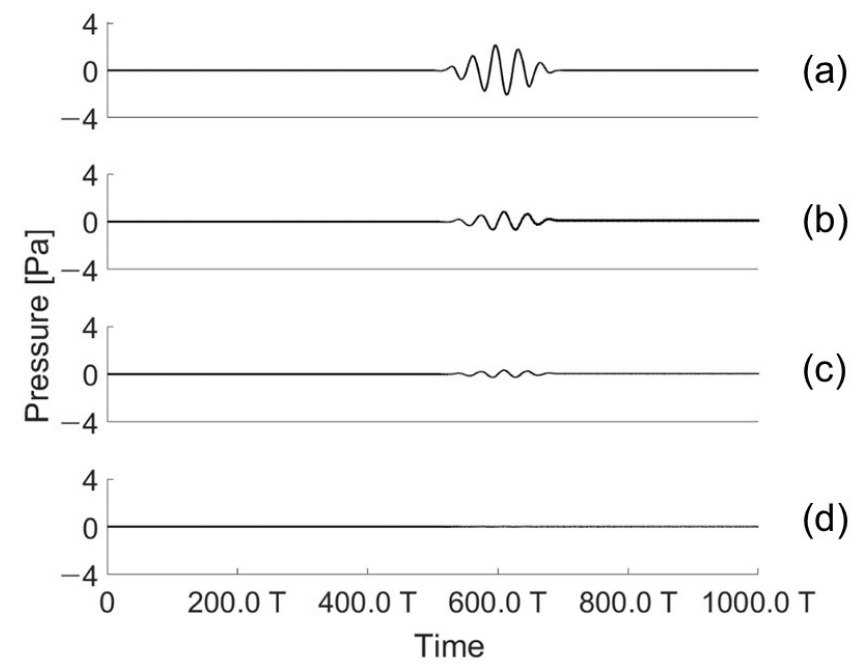
Figure 14. Acoustic signals emitted in the perpendicular direction when the array transducer is activated: ( a ) one; ( b ) two; ( c ) five; and ( d ) hundreds of transducers (at 30 ◦